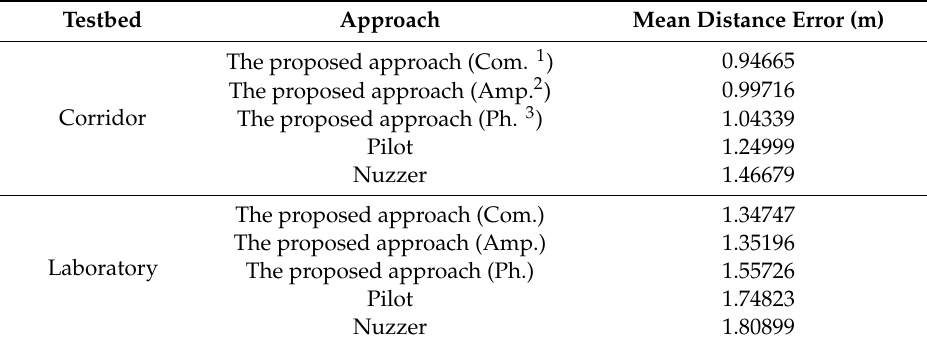
Table 3. Localization performance in two typical indoor